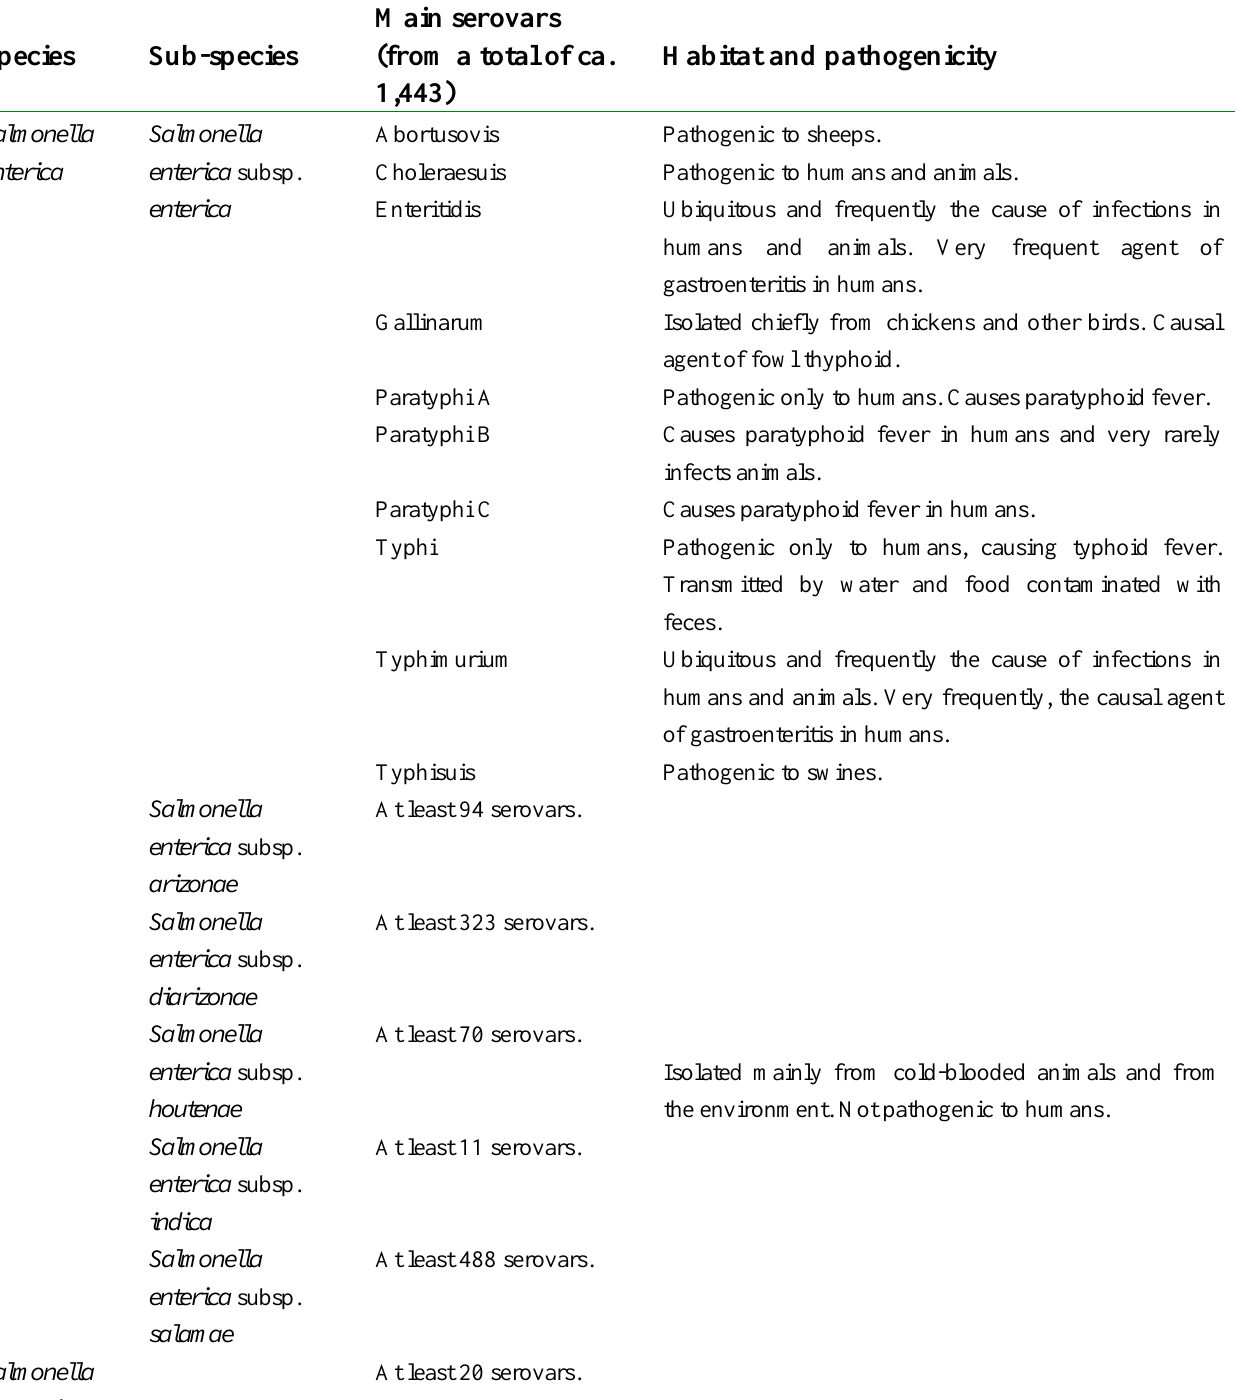
Table 4. Current taxonomy and nomenclature of the genus Salmonella . Habitat and pathogenicity of main serovars a